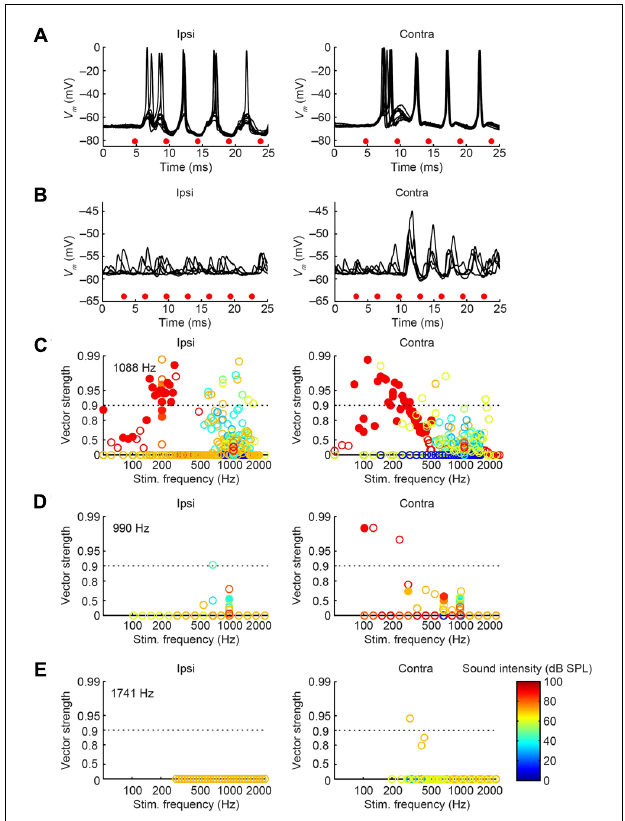
FIGURE 13 | Phase-locking of mLNTB neurons to tones. Left column: responses to ipsilateral tones. Right column: responses to contralateral tones. (A,B) V m traces for two neurons; (C–E) plots of VS for three neurons. (A) Stacked responses to ipsilateral (left) and contralateral (right) tones of 210 Hz at 90 dB SPL (CF = 1088 Hz). Red dots indicate stimulus periods. VS is 0.94 ( α ≤ 0.001) for ipsilateral stimulation and 0.96 ( α ≤ 0.001) for contralateral stimulation. (B) Similar to (A) , for another neuron (CF = 1741 Hz), for tones of 309 Hz at 70 dB SPL. (C) VS as a function of stimulus frequency, for the neuron in (A) . Filled symbols correspond to data with significant phase-locking. Colors indicate sound levels (scale in E ). CF is indicated in the left panel. Dashed line indicates a VS of 0.9. (D,E) Similar to (C) , for other mLNTB neurons. The neuron in (E) corresponds to the neuron in (B) .